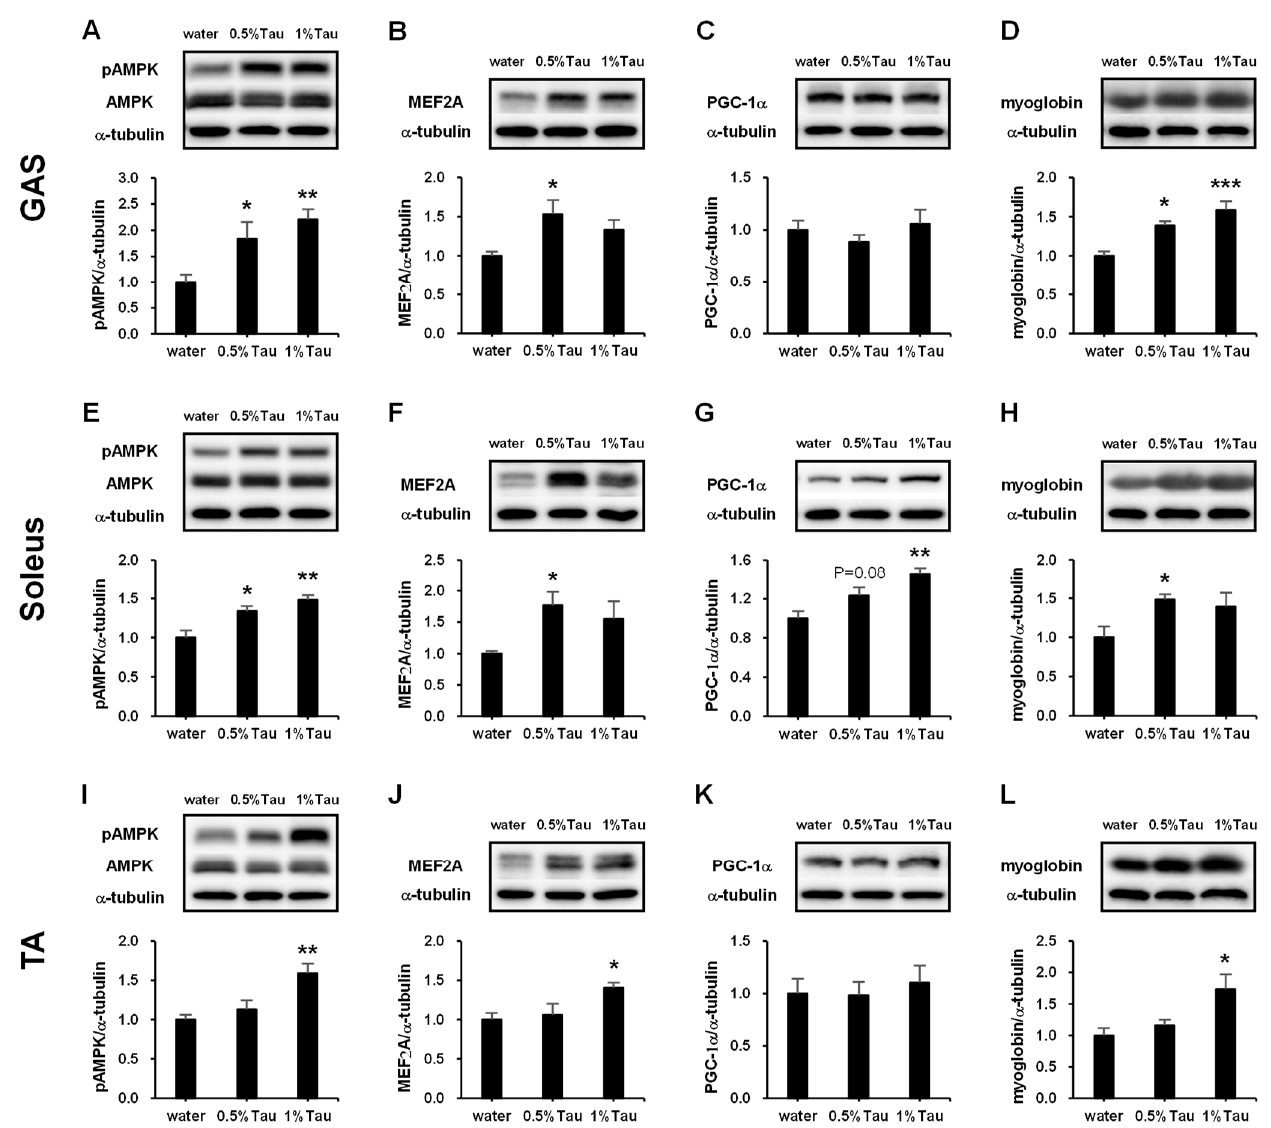
Figure 3. Effects of short-term taurine supplementation on the phosphorylation of AMP-activated protein kinase (AMPK) ( A , E , I ) and expression levels of MEF2A ( B , F , J ), PGC-1 α ( C , G , K ), and myo- globin ( D , H , L ) proteins in GAS, soleus, and TA muscles of rats in the water, 0.5% taurine, and 1% taurine groups. Skeletal muscles of SD rats at 14 weeks of age were collected 4 h after administration on the 10th day. The administration levels of taurine are indicated in Figure 1. Proteins were extracted and analyzed by Western blot as described in the Materials and Methods section. Values shown represent the mean ± SE (n = 3–6). * p < 0.05, ** p < 0.01, *** p < 0.001, statistically significant vs. the values of the water group. Results were analyzed using Dunnett’s test.